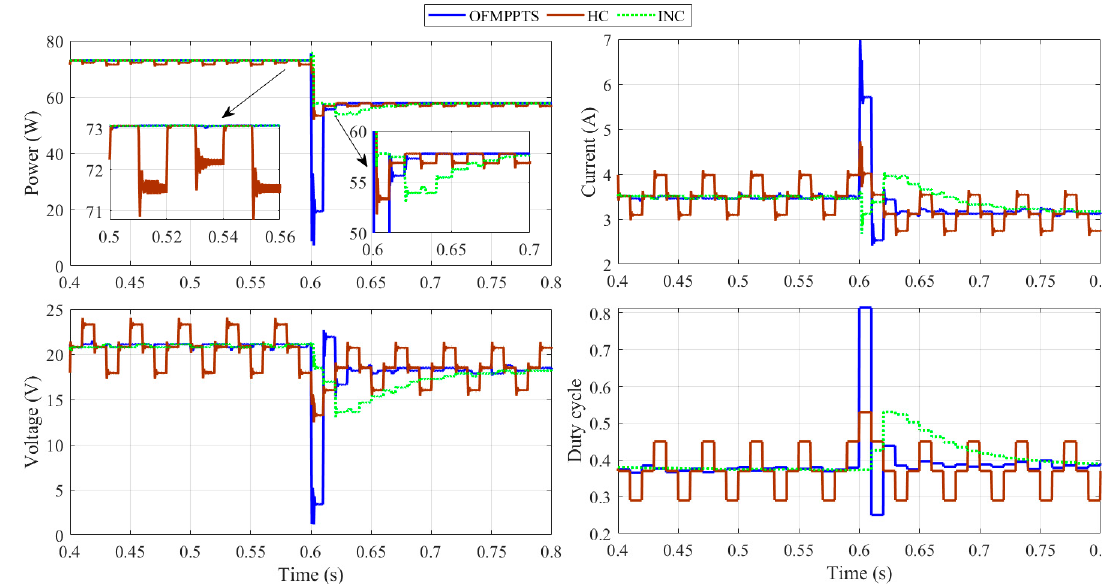
Figure 11. Dynamic tracking performance using OFMPPTS, HC, and INC methods for 2nd scenario.